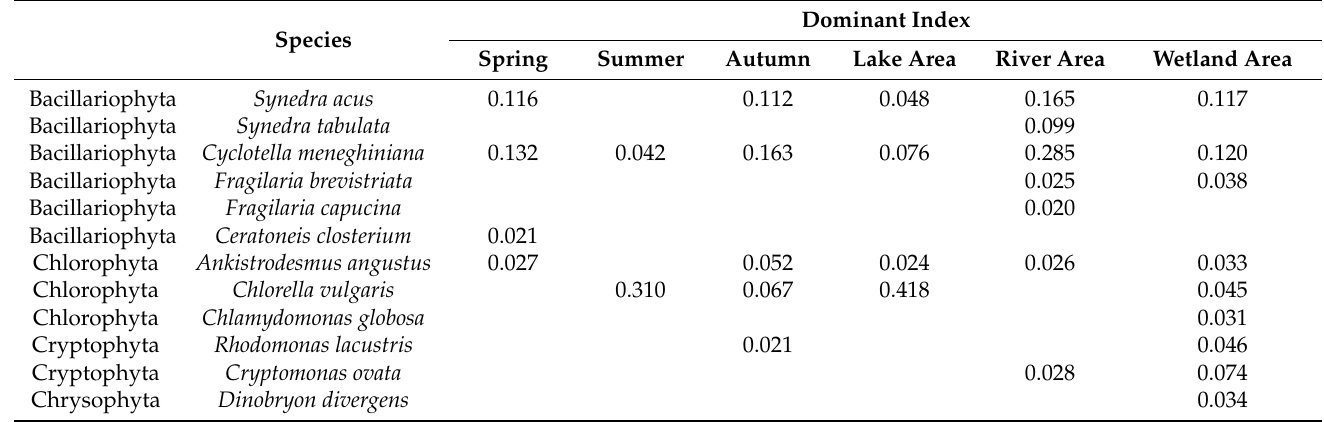
Table 1. Distribution of dominant phytoplankton species within Zhalong National Nature Reserve.